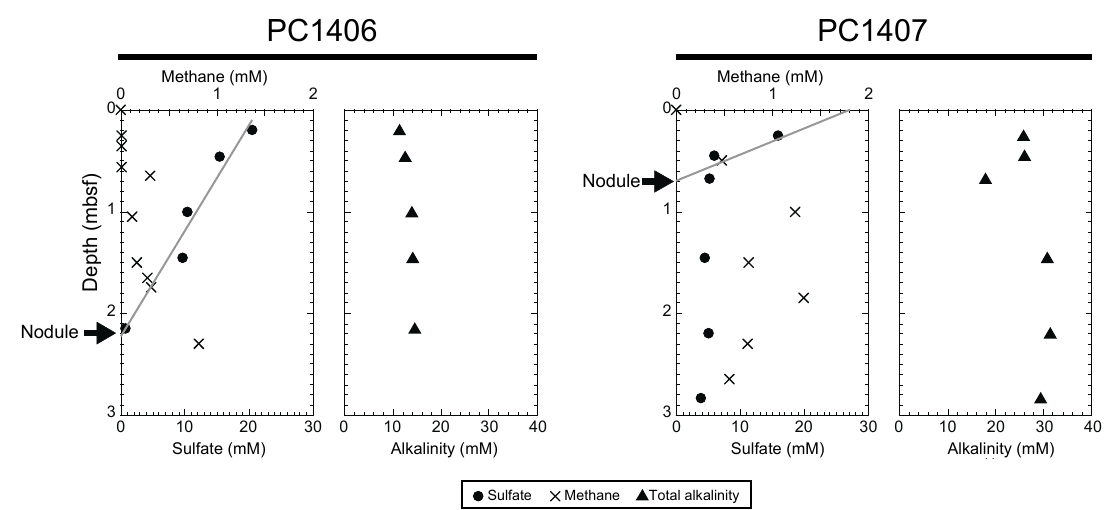
Figure 2. Depth profiles of pore water sulfate, methane, and total alkalinity in the PC1406 and PC1407 cores. Circles, sulfate; crosses, methane; triangles, total alkalinity. Nodules PC1406 and 1407 were collected at the same depth as sulfate-depletion, which was defined by the linear regressions of sulfate. Carbon isotopic values of the nodules PC 1406 and PC1407 ranged from − 38.05% (cid:24) to − 37.32% (cid:24) ,